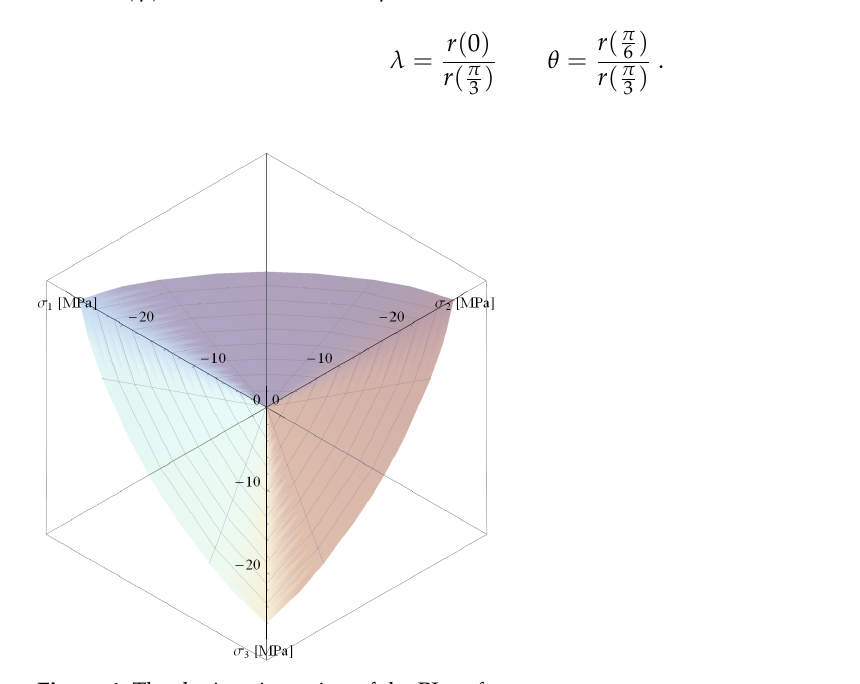
Figure 4. The deviatoric section of the PJ